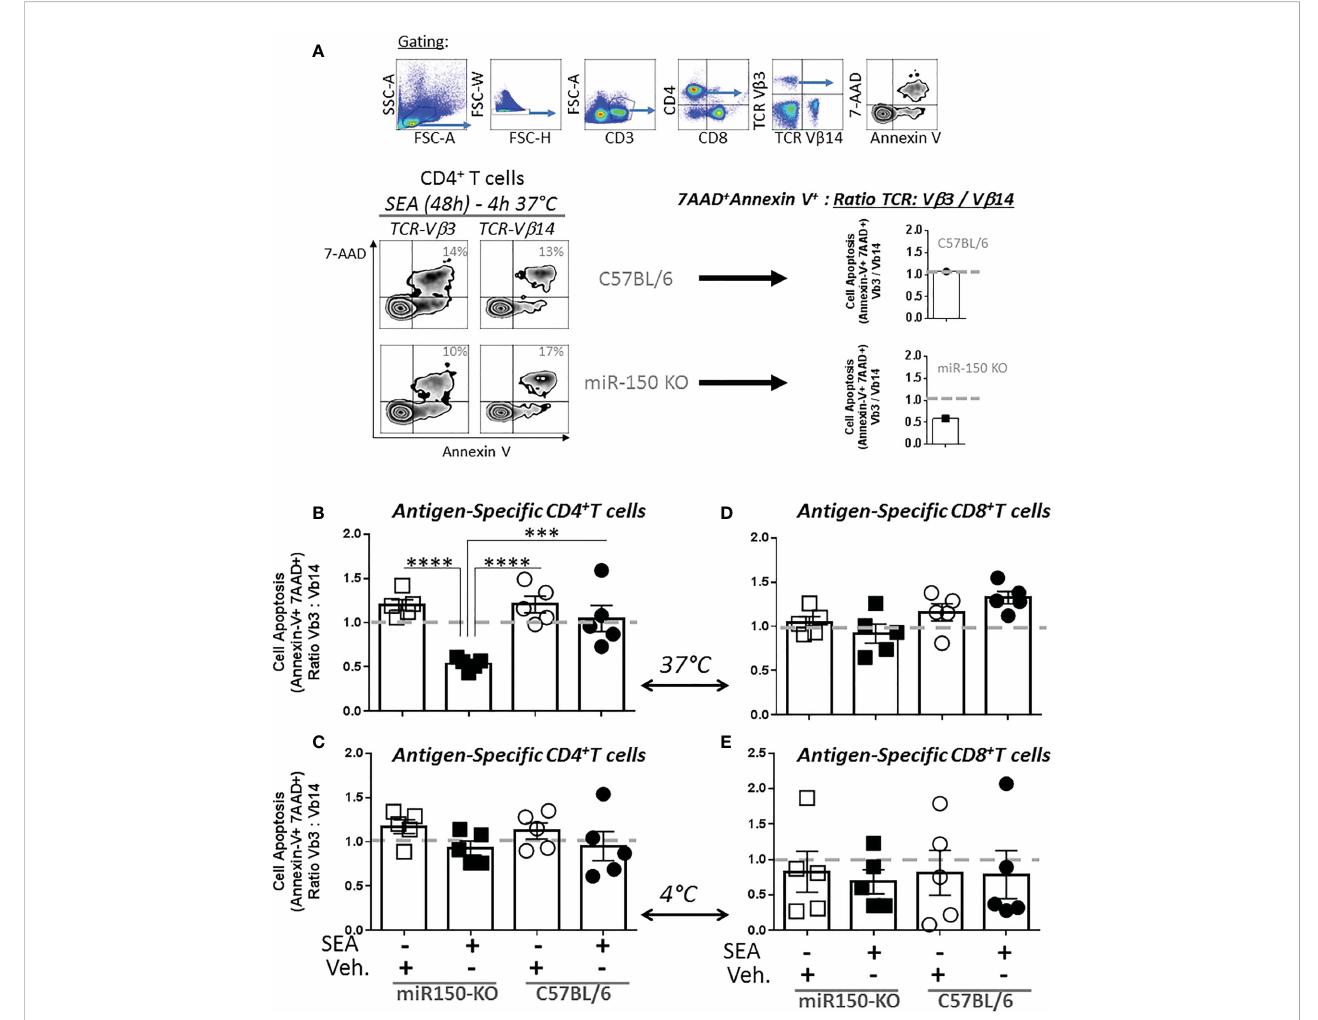
FIGURE 5 miR-150 regulates apoptosis of antigen-speci fi c CD4 + T but not CD8 + T cells. (A) Splenocytes from miR-150-KO and WT mice analyzed 48h post-SEA and post-vehicle challenge and 4 h post-incubation ex vivo for expression of apoptotic markers (7AAD, Annexin V) and reported as a ratio of TCR: antigen-speci fi c (V b 3) vs. bystander (V b 14). (B) Analysis of antigen-speci fi c CD4 + T cells incubated for 4 h at 37°C or (C) bystander CD4+ T cells incubated for 4 h at 4°C is shown. (D) Analysis of antigen-speci fi c CD8 + T cells incubated 4h at 37°C or (E) bystander CD8+ T cells incubated 4h at 4°C is shown. Each dot represents a biological replicate, fi ve independent experiments are shown +/- s.e.m. Statistical signi fi cance was evaluated by 2 way ANOVA. (***p < 0.001; ****p <